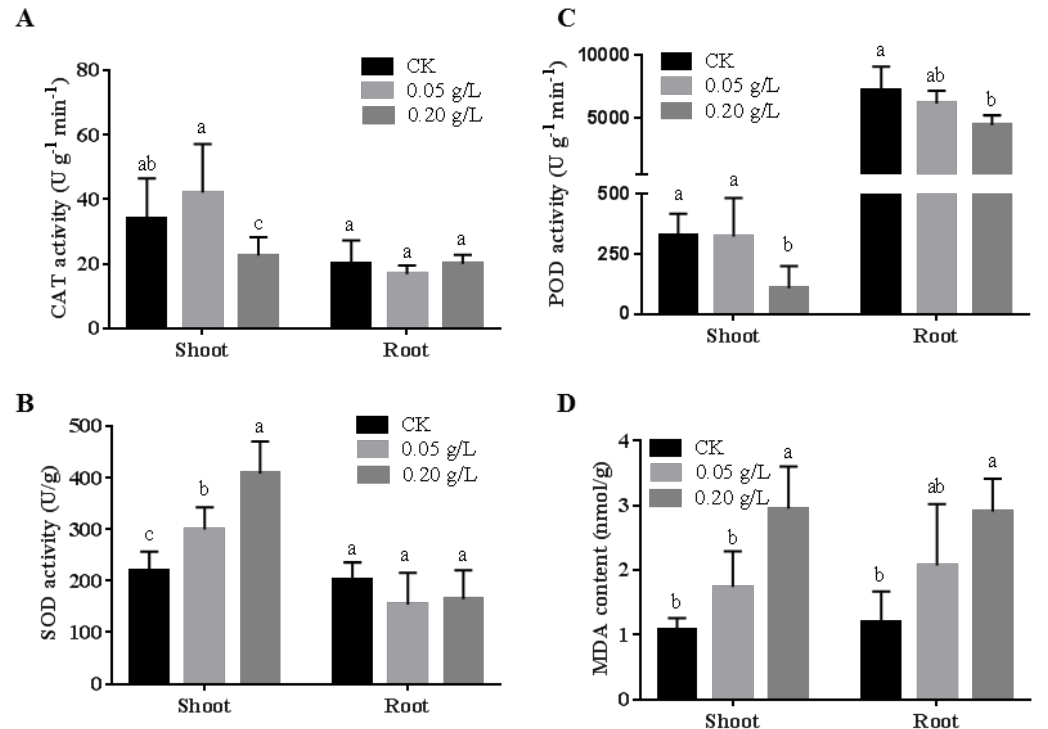
Figure 7. The enzyme activities and malondialdehyde (MDA) content in shoot and root of Brassica napus under different CMS treatments. CK is a full-strength Hoagland’s solution. Two concentrations (0.05 and 0.20 g L −1 ) of CMS were added to the Hoagland’s solution. (A) The CAT activity; (B) The SOD activity; (C) The POD activity; ( D ) The MDA content. Different letters indicate the significant differences at P < 0.05 by Duncan’s test. Data are means ± SD with four biological replicates.